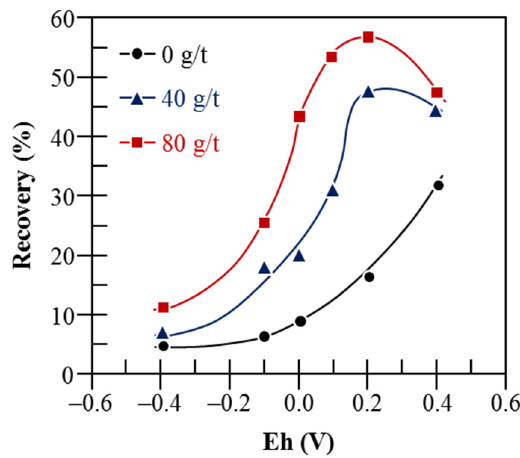
Figure 7. Recovery of chalcopyrite as function of Eh and butyl xanthate addition at pH 8.1 (reprinted with permission from Grano et al. [39], copyright (1990) Elsevier).